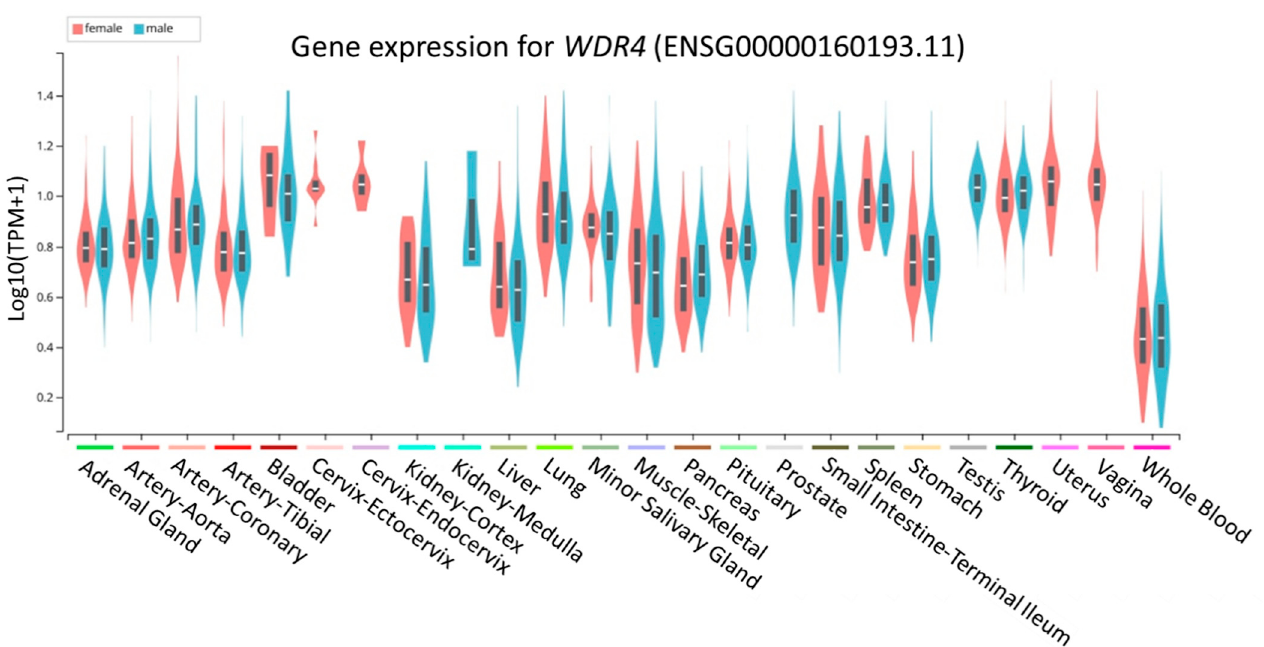
Figure 3. Profile of WDR4 gene expression in various tissues. Blue represents the male gender and red the female gender.